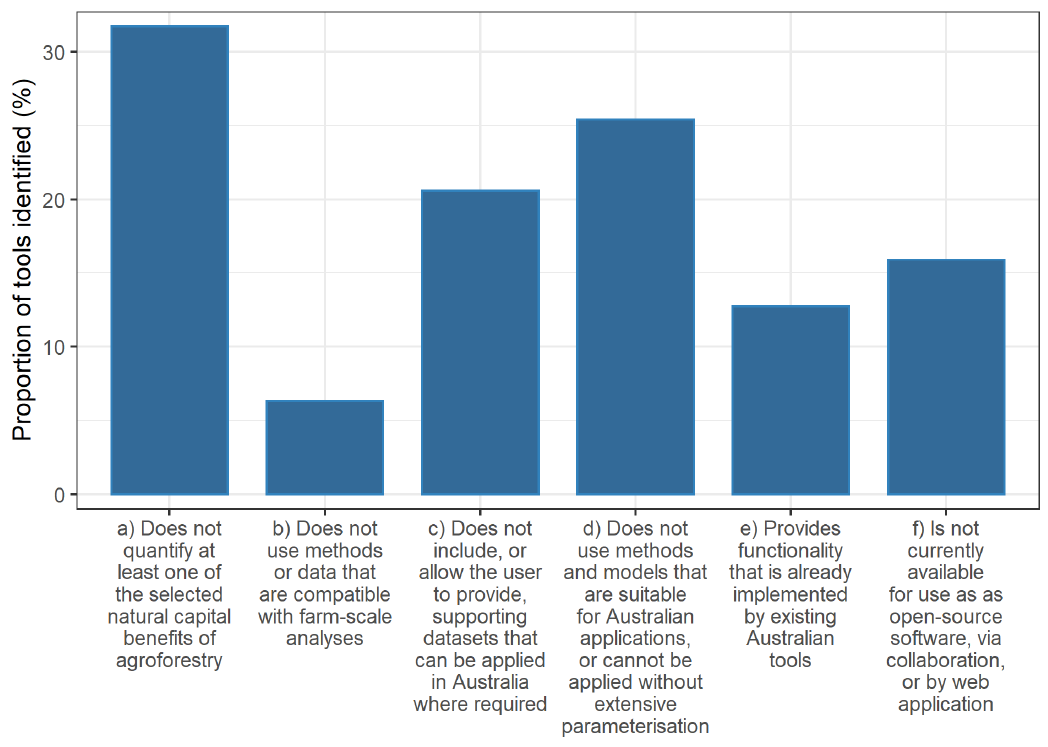
Figure 2. Proportion of tools identified ( n = 63) that did not meet the respective suitability criteria for detailed evaluation of modelling capabilities.